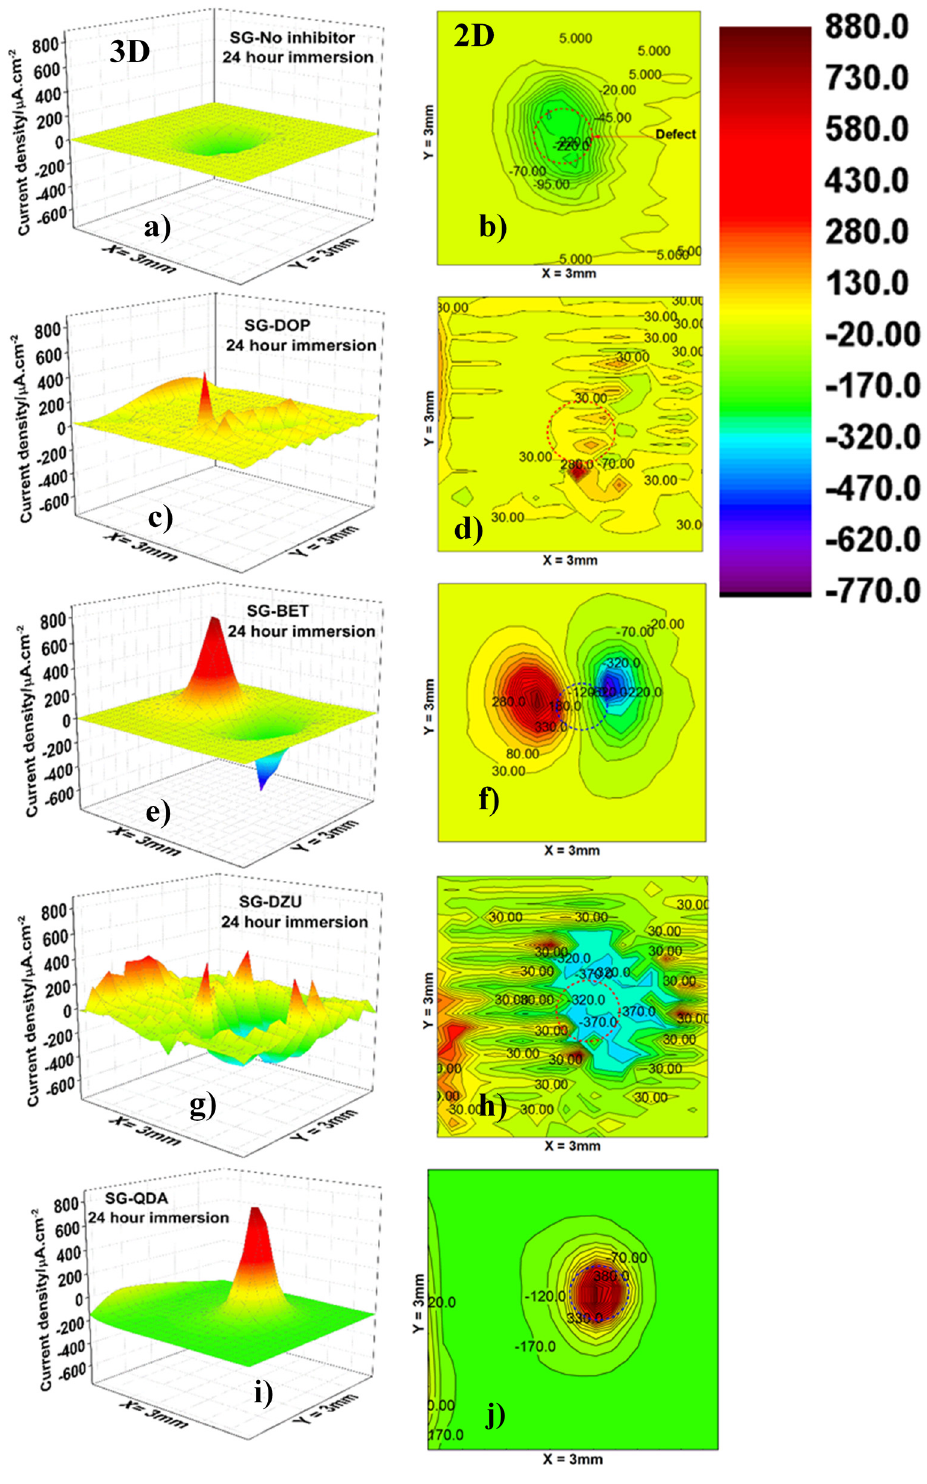
Figure 7. SVET 3D and 2D mapping of sol-gel coated Mg AZ31B, with and without inhibitors.